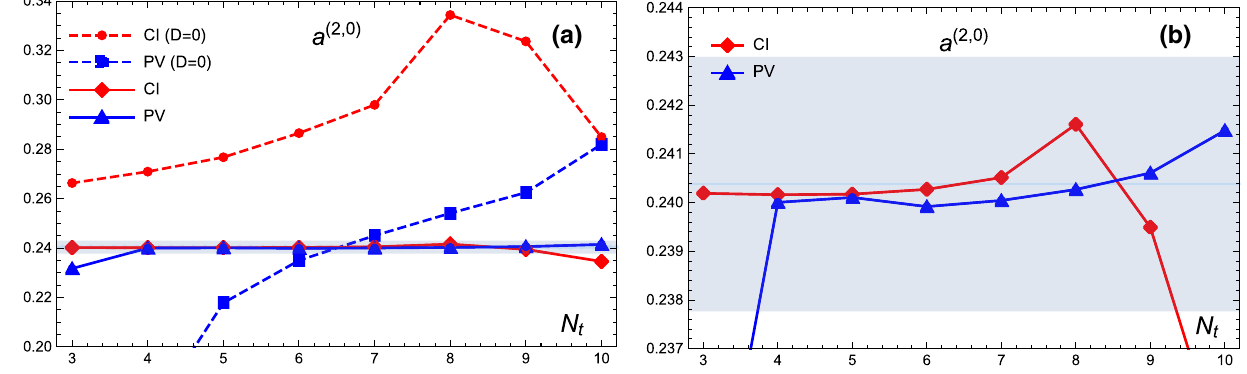
Fig. 6 a The moment a ( 2 , 0 ) (σ m ) as a function of the truncation index N t , in the CIPT (’CI’) and PV approaches. The red diamonds and the black triangles are the CIPT and PV full results, i.e., with the corre- sponding condensate values; the red circles and the black squares are